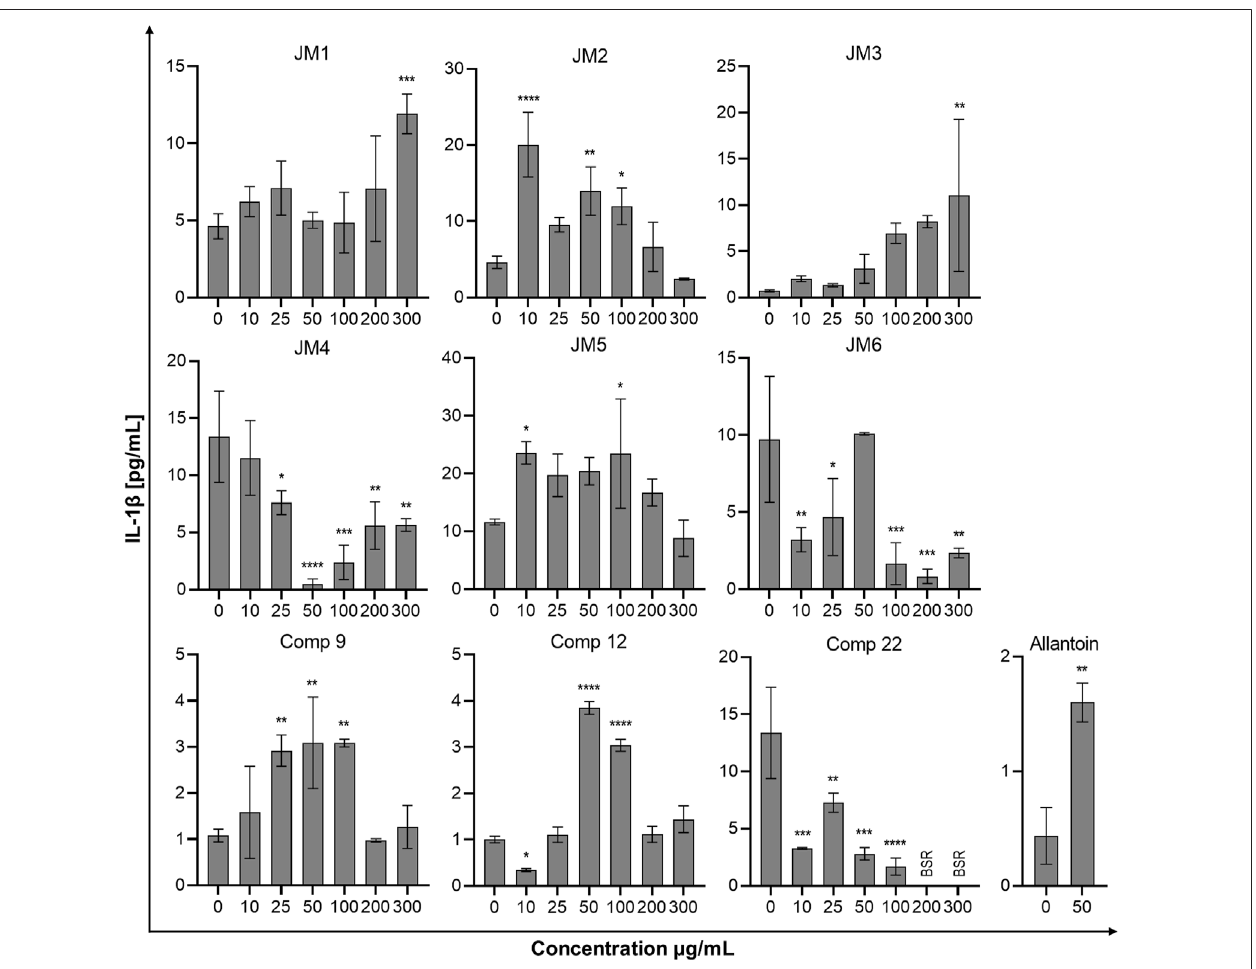
FIGURE3| Effectsofthe J.montana extracts JM1 – JM6 andtheirmaincomponents( 9 , 12 ,and 22 )(10 – 300 μ g/mL)andallantoin(50 μ g/mL)onIL-1 β production inhibition.Meanvaluesfromthreeindependentexperiments(n=3)performedinduplicatearepresented.* p < 0.05versusthecontrolgroup,** p < 0.01versusthecontrol group, *** p < 0.001 versus the control group, **** p < 0.0001 versus the control group. BSR, below the standard range (values lower than the detection limit).